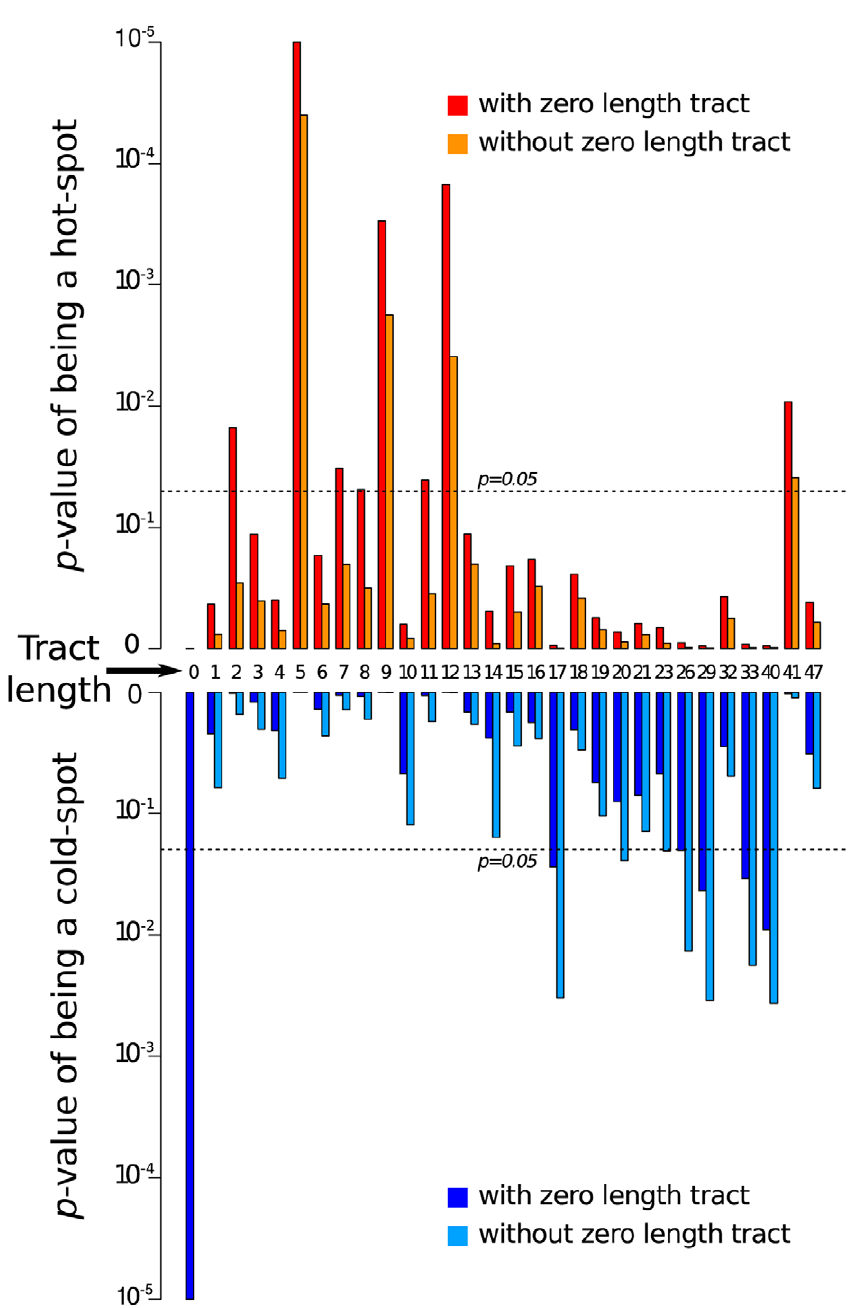
Figure 4. Breakpoints arising during mixed infections tend to fall significantly more frequently at sites where Tomatoyellowleafcurl virus (TYX) and TomatoleafcurlComorosvirus (TOX) share identical stretches of between 5 and 12 nucleotides and significantly less frequently at sites where they share 17 or more identical nucleotides. The high frequency of recombination breakpoints within the 41 nucleotide long site category is attributable to this being the virion strand origin of replication (a known recombination hotspot). perfect identity greater than 16 nucleotides long tend to be less recombinogenic than expected (five p -values for tract lengths in this size class , 0.05 when zero length tract sizes are considered and six when they are excluded) and; (4) the 41 nucleotide tract of 100% TYX and TOX identity surrounding the stem-loop region encounters more recombination breakpoints than can be account- ed for by chance ( p = 0.0092 when zero length tracts are included in the analysis and p = 0. 0388 when they are excluded; Figure 4).